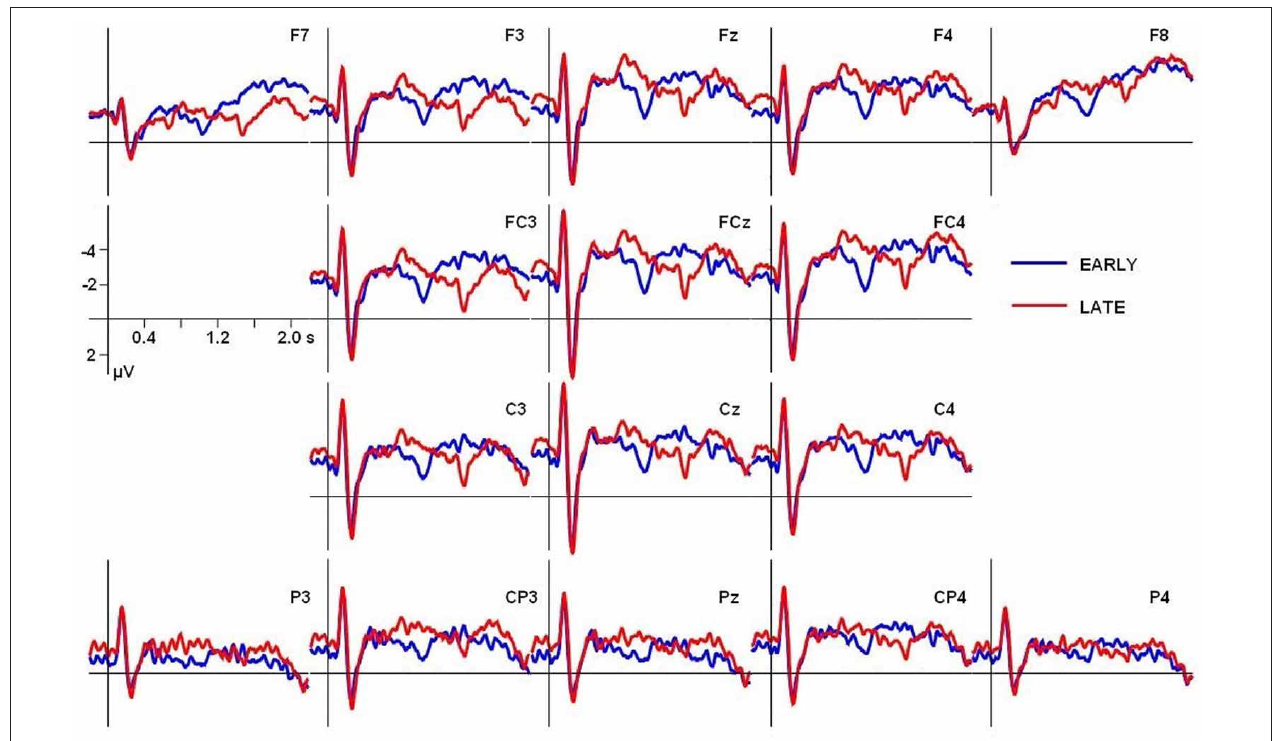
FIGURE 6 | Grand average ERPs for both conditions adjusted to a baseline from 200 to 400ms after stimulus onset, covering stimulus initial onset